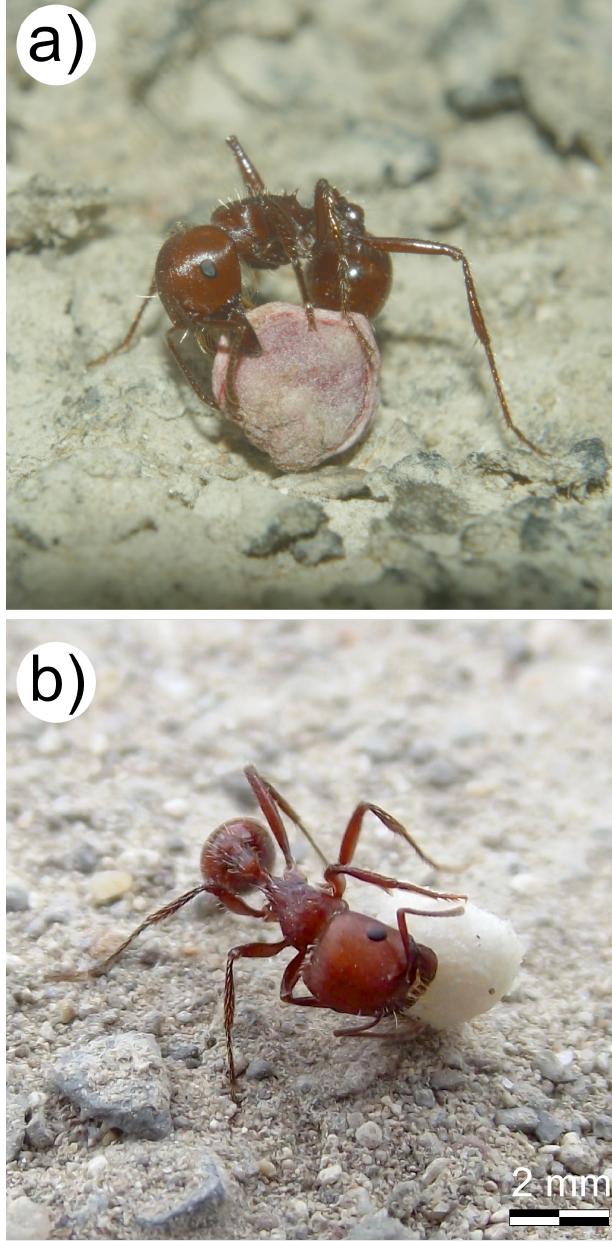
Fig 1. Workers of Pogonomyrmex barbatus (Myrmicinae) manipulating seeds: (a) of Opuntia pilifera (Cactaceae) and (b) artificial seeds with lipids (9% of the content). Photo credits: (a) J. H. García-Chavez and (b) P. We used three types of seeds: a non-artificial native seed from Opuntia pilifera F.A.C. Weber (Cactaceae) (mean size ± SE: